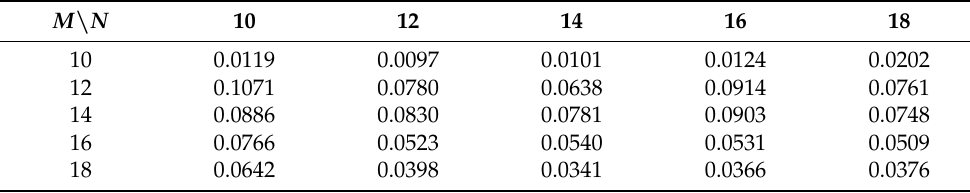
Table 4. Newton errors of the last iteration for u x obtained with Legendre collocation with different meshes ( N denotes the number of horizontal collocation points and M denotes the number of vertical collocation points); Ra = 1300, Γ = 27.96, np = 14, and mp = 2. M \ N 10 12